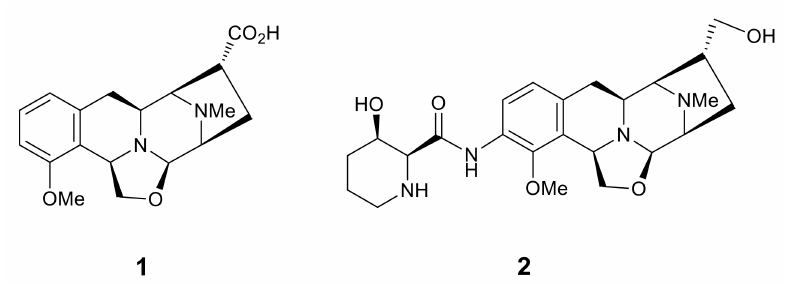
Figure 1. Molecular structures of quinocarcin ( 1 ) and tetrazomine ( 2